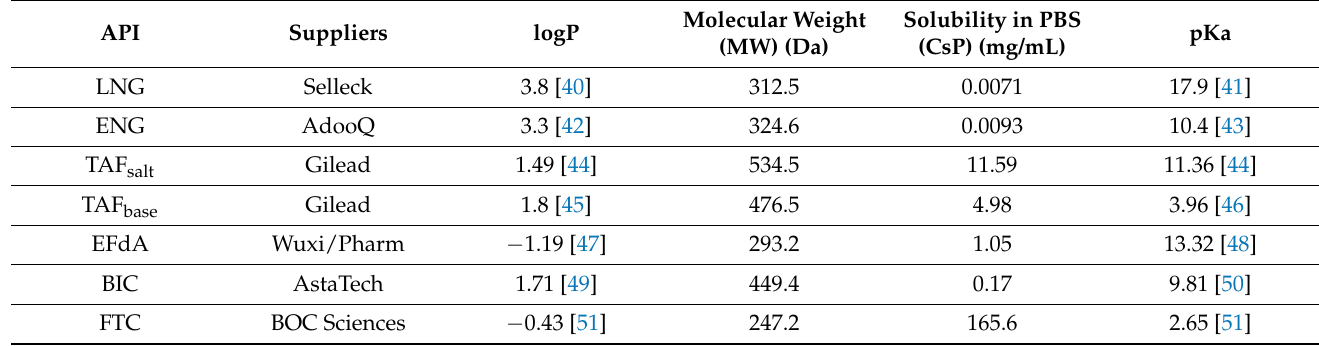
Figure 1. ( Left ) A schematic of a PCL reservoir-style implant containing formulated API inside the reservoir and the dissolved drug releasing into to the surrounding medium. ( Right ) A digital camera image of a 10mm-long biodegradable implant containing surrogate drug formulation. Table 1. Physical properties and sources of APIs used to develop the model.